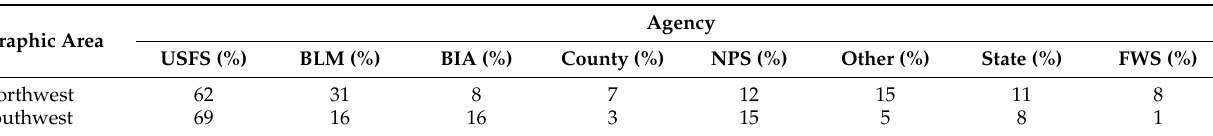
Table 1. U.S. jurisdictional composition of the sample fires (Northwest, 133; Southwest, 149) reflecting the multijurisdictional nature of fire management, with many agencies sharing responsibility for one wildfire, regardless of the ownership of the point of fire origin.